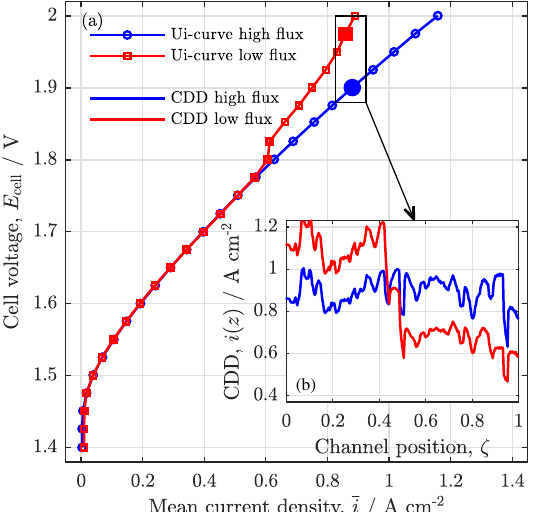
Figure 1. Experimental results from the analysis of high and low water stoichiometry operation on ( a ) the polarization curves and ( b ) the current density distribution (CDD). In ( a ): the blue line with circles shows results from experiments with a high water stoichiometry, the red line with squares shows the results from experiments, in which water ratios of λ st ≤ 5 are reached for mean current densities of ¯ i ≥ 0.6Acm − 2 . In ( b ): CDD for high (blue) and low (red line) stoichiometry operations at a common mean current density of ¯ i ≤ 0.85Acm − 2 are shown along the channel coordinate ( ζ ). The experimental setup is briefly described in the Appendix C. Data and comprehensive experiment description in Immerz et al.